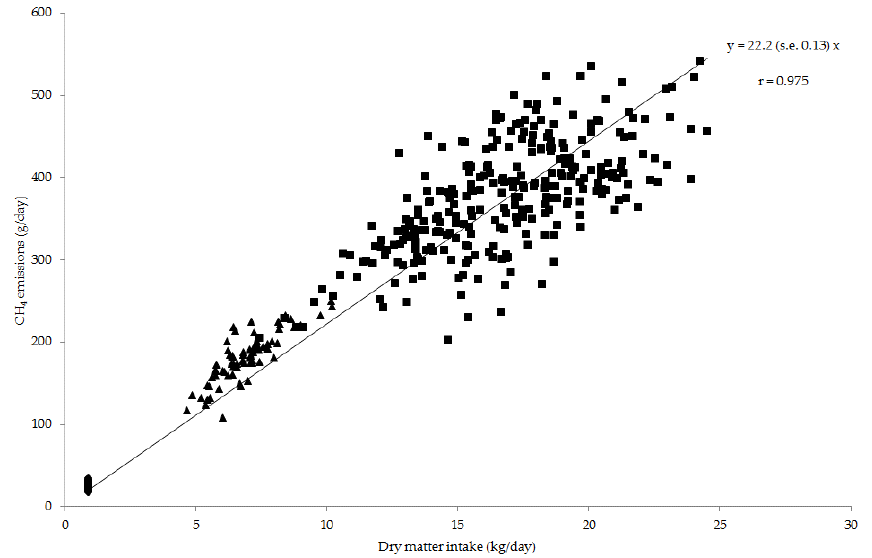
Figure 1. Observed dry matter intake and CH 4 emissions per day for sheep ( ♦ ; n = 288), beef cattle ( ▲ ; n = 71) and dairy cows ( ■ ; n = 284) included in the analysis. The line of best-fit through the origin across all values is shown with the Pearson correlation coefficient ( r ).